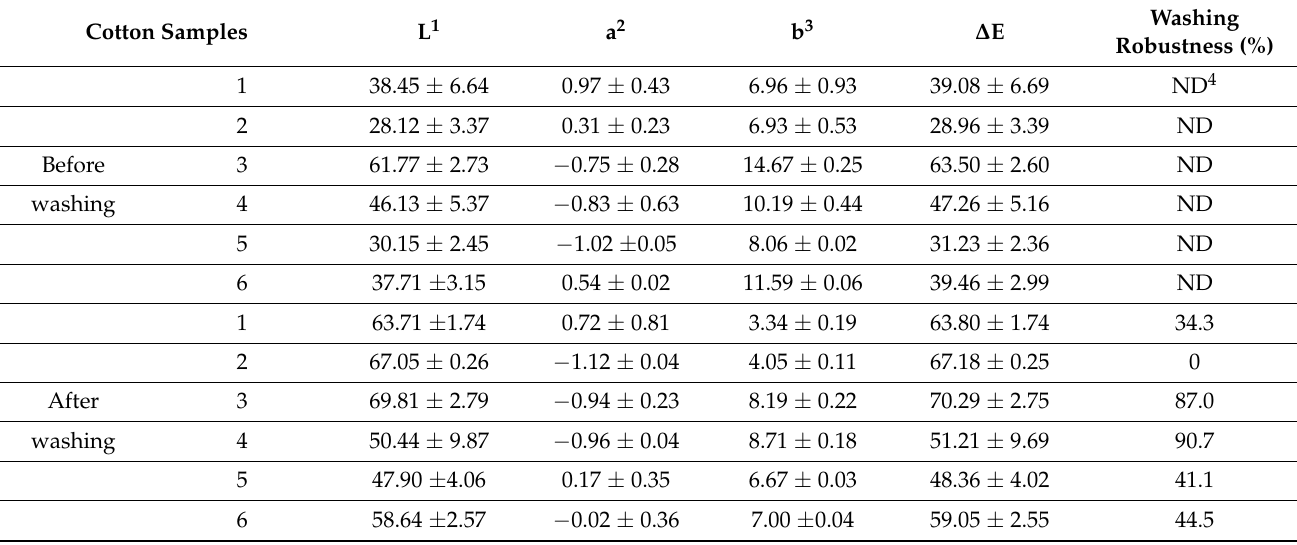
Table 1. Color differences of S. glaucescens melanin-dyed cotton